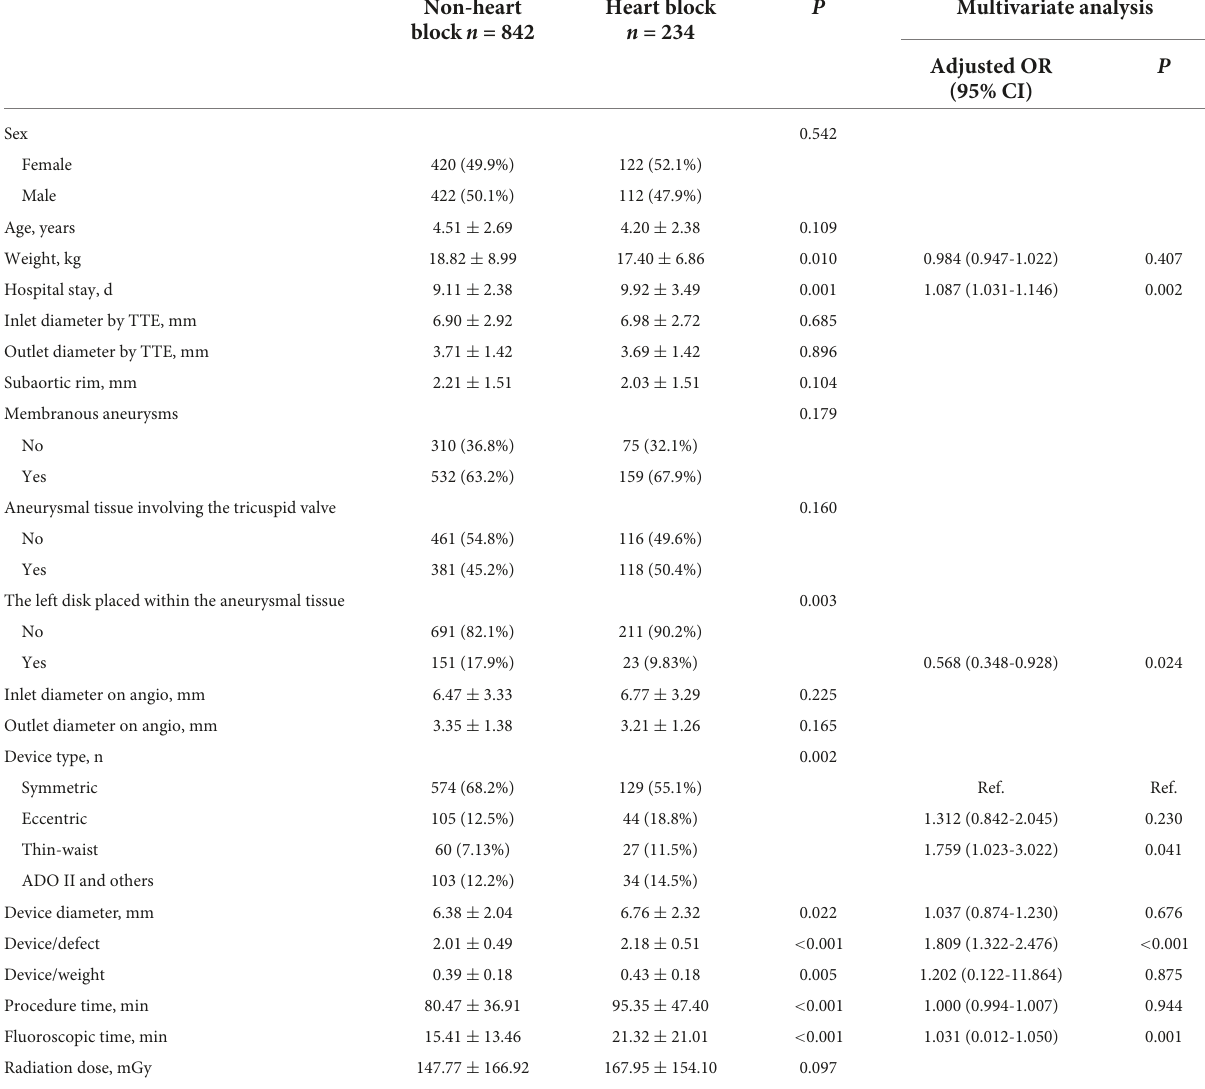
TABLE 5 Risk factors for occurrence of heart